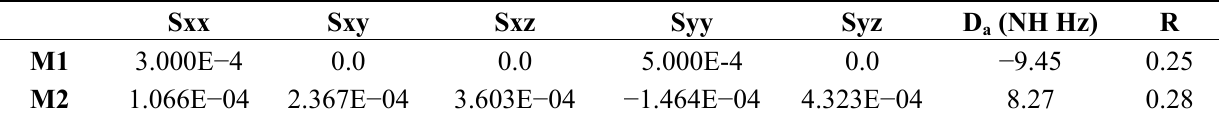
Table 10 . Two order tensors used for generation of simulated data. These order tensors closely mimic other experimentally observed order tensors.